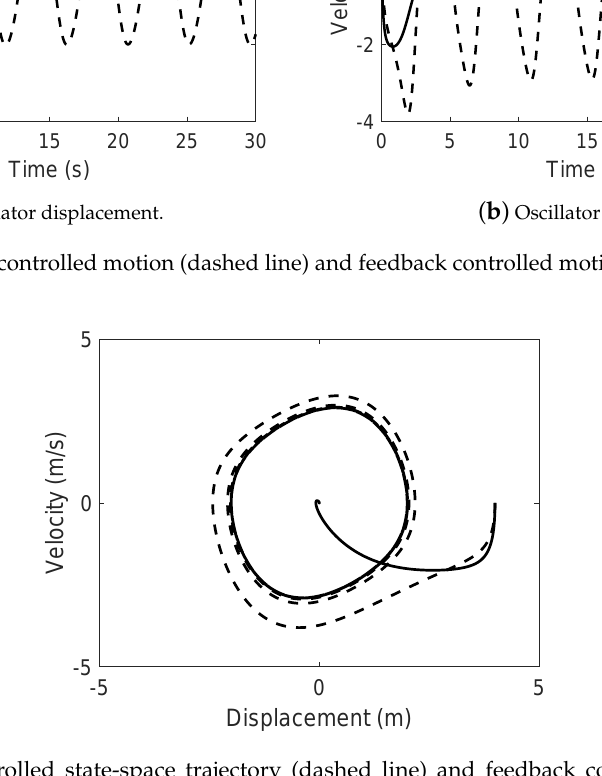
Figure 8. Uncontrolled state-space trajectory (dashed line) and feedback controlled state-space trajectory (solid line).